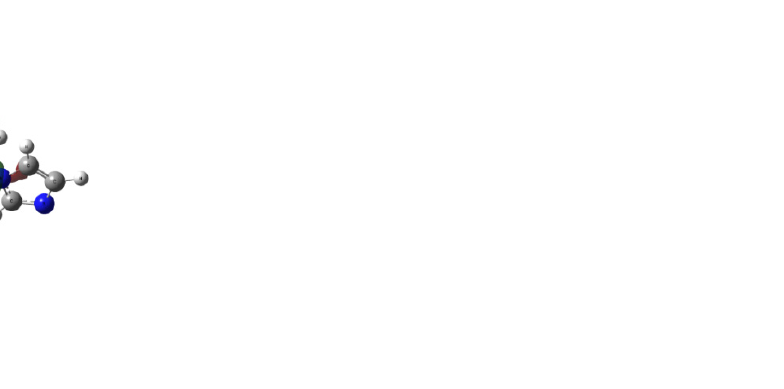
Figure 8. The HOMO orbitals generated for compound 1 ( up ; rotamer optimized at the B3LYP/6-31G(d,p) level of theory in methanol) and 2 ( down ; rotamer optimized at the wB97XD/6-31G(d,p) level of theory in methanol); vertical excited states calculated at the functional/6-311++G(2d,3p) level of theory (functional: B3LYP or wB97XD for 1 or 2 , respectively).